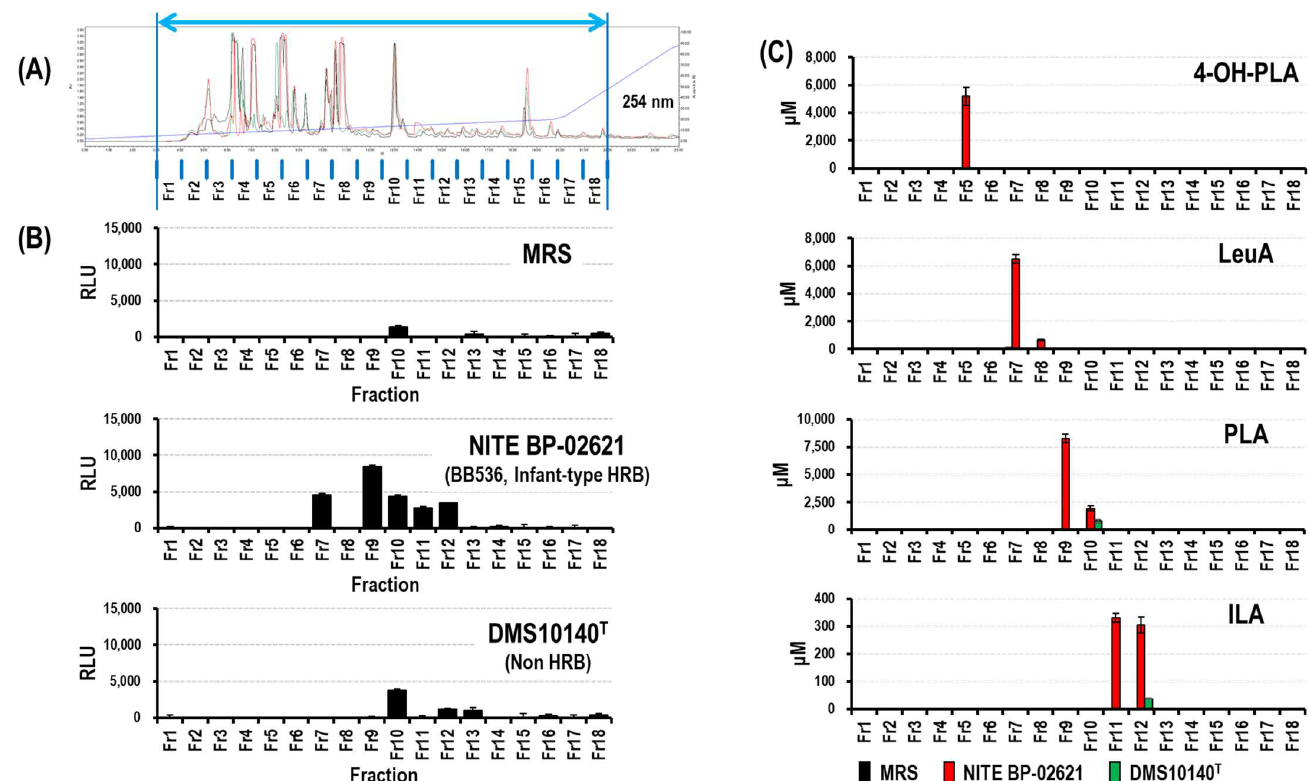
Figure 2. Fractionation of culture supernatants of Bifidobacterium strains. ( A ) HPLC, HPLC-DAD chromatograms (detector λ254 nm) of CSs and MRS. CS of B. longum subsp. longum (NITE BP-02621, infant-type HRB) (red line) and CS of B. animalis subsp. lactis (DSM10140 T , non-HRB) (green line) and MRS (black line). The fractions were collected every 1 min (from 3–22 min) and numbered from fractions 1–18. ( B ) HCA 3 activity of the 18 fractions of MRS and CSs of NITE BP-02621 and DSM10140 T . The values shown are the mean values (RLU) of triplicates ± SD. RLU, relative light units that were subtracted from the PBS baseline. ( C ) Concentration of 4-OH-PLA, LeuA, PLA, and ILA in 18 fractions. Fractions MRS (black); NITE BP-02621 (red); and DSM10140 T (green). The values shown are the mean values (μM) of triplicates ± SD.